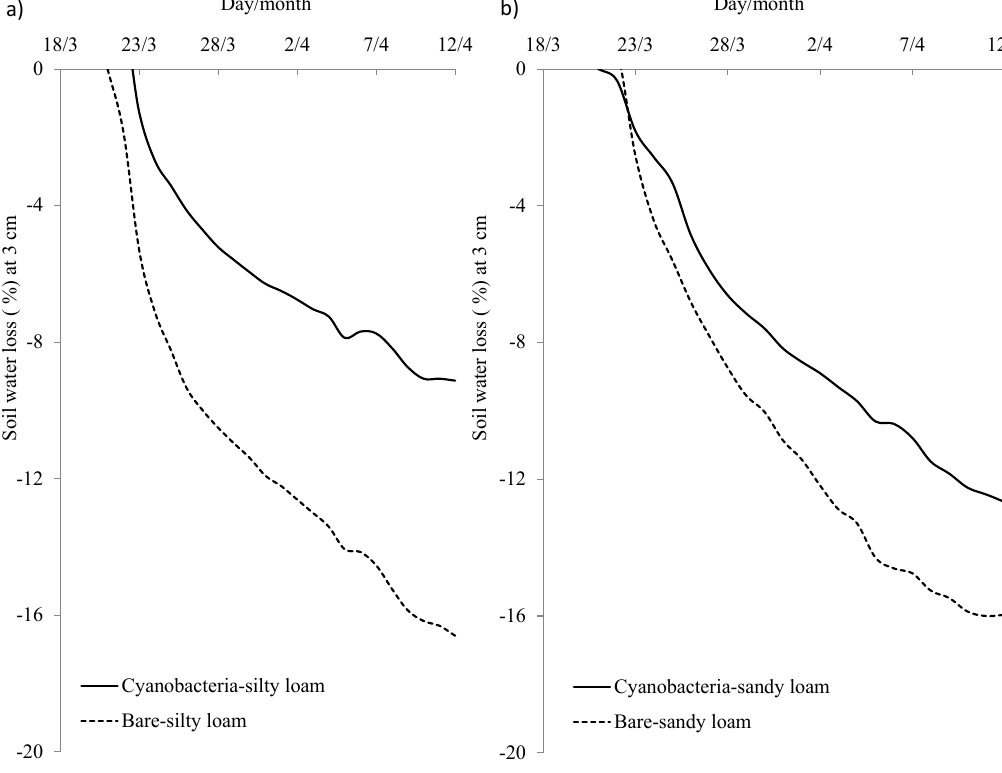
Figure 7. Soil water loss (%) during the drying soil period from 21 March to 12 April 2010 in soils covered by cyanobacterial biocrusts and bare soils (where the biocrust was removed) at both study sites, ( a ) El Cautivo (silty loam soils) and ( b ) Las Amoladeras (sandy loam soils).